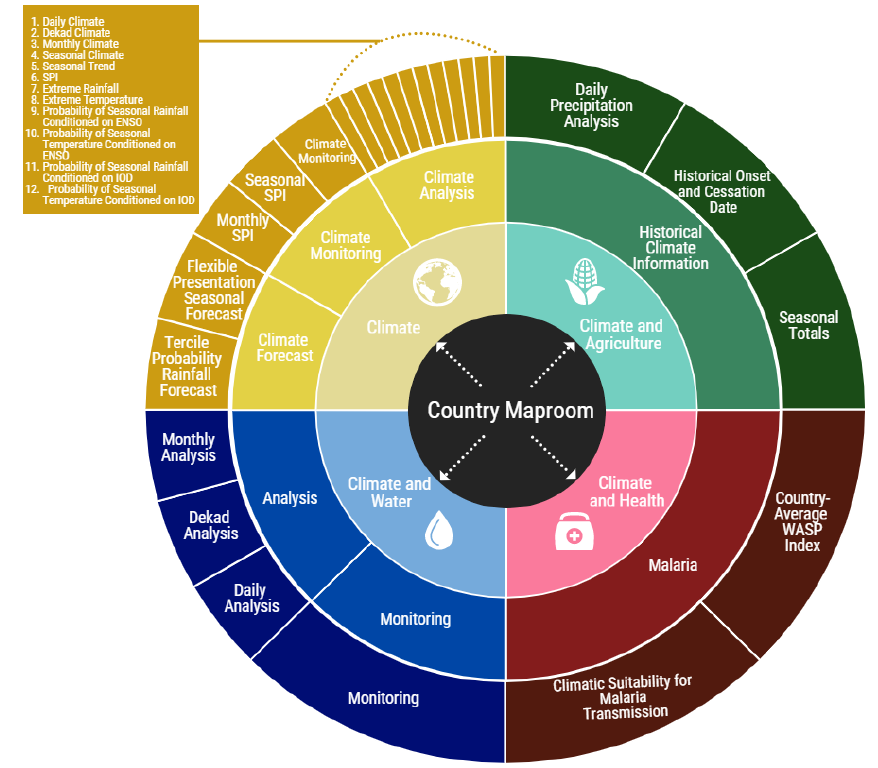
Figure 2. Circular diagram showing the sub-maprooms of the ENACTS Maproom, potential uses, and the related products in concentric circles. Different sub (branch) maprooms are observed as one goes out from the center of the